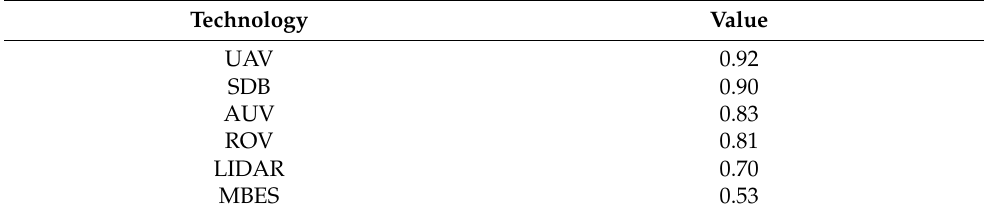
Table 8. Ranked technologies for the survey